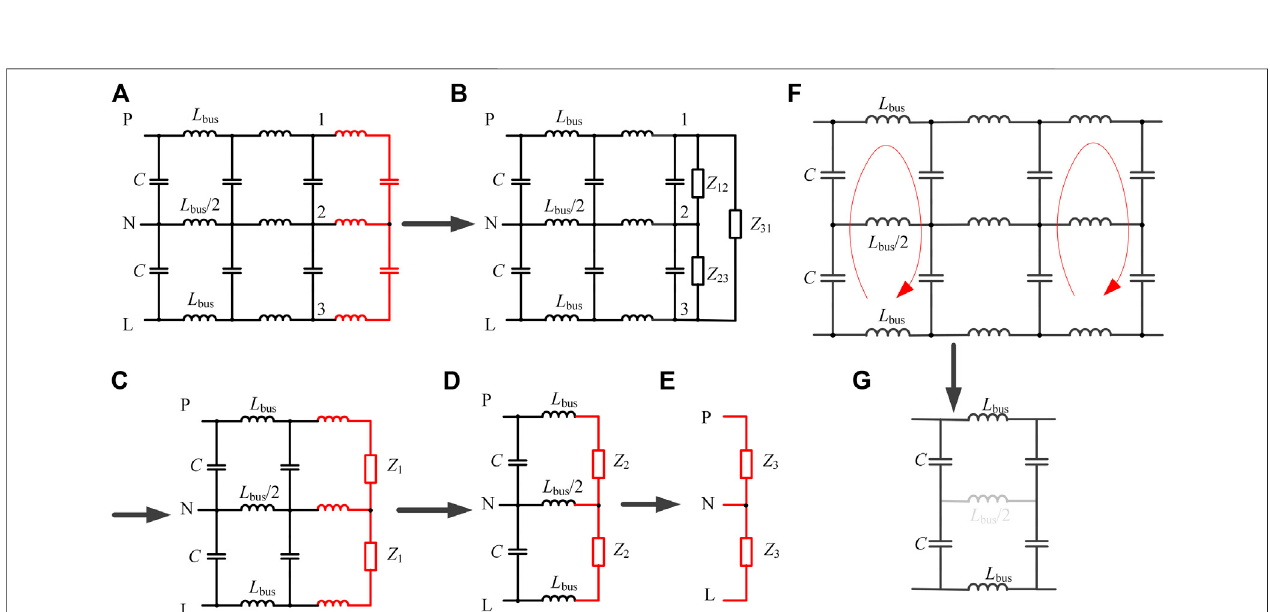
FIGURE 6 | (A – E) The equivalent solution process of port impedance circuit (F,G) Partition unit of the capacitor module.